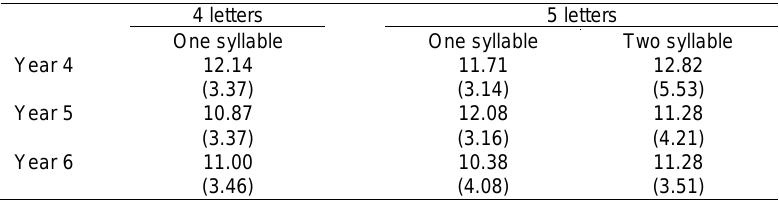
Table 3. Mean number of trial used by English children to success in the